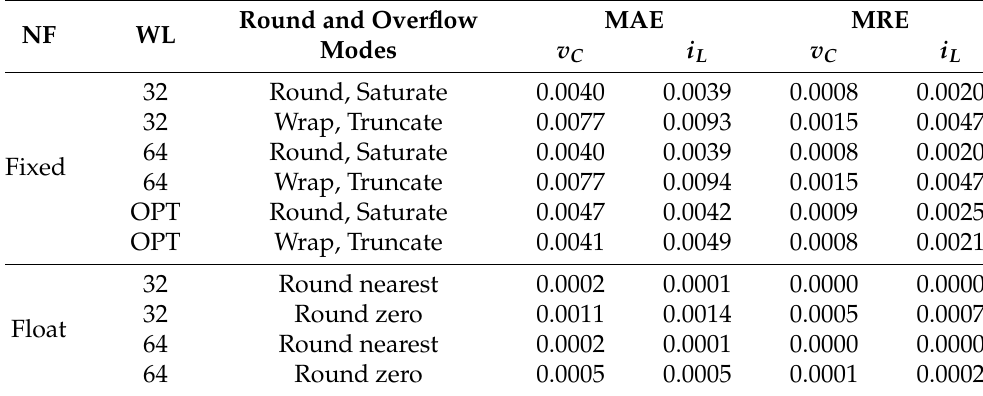
Table 2. Mean absolute (MAE) and relative error (MRE) in the state variable i L and v C for the different numerical formats (NFs), word lengths (WLs) and rounding and overflow